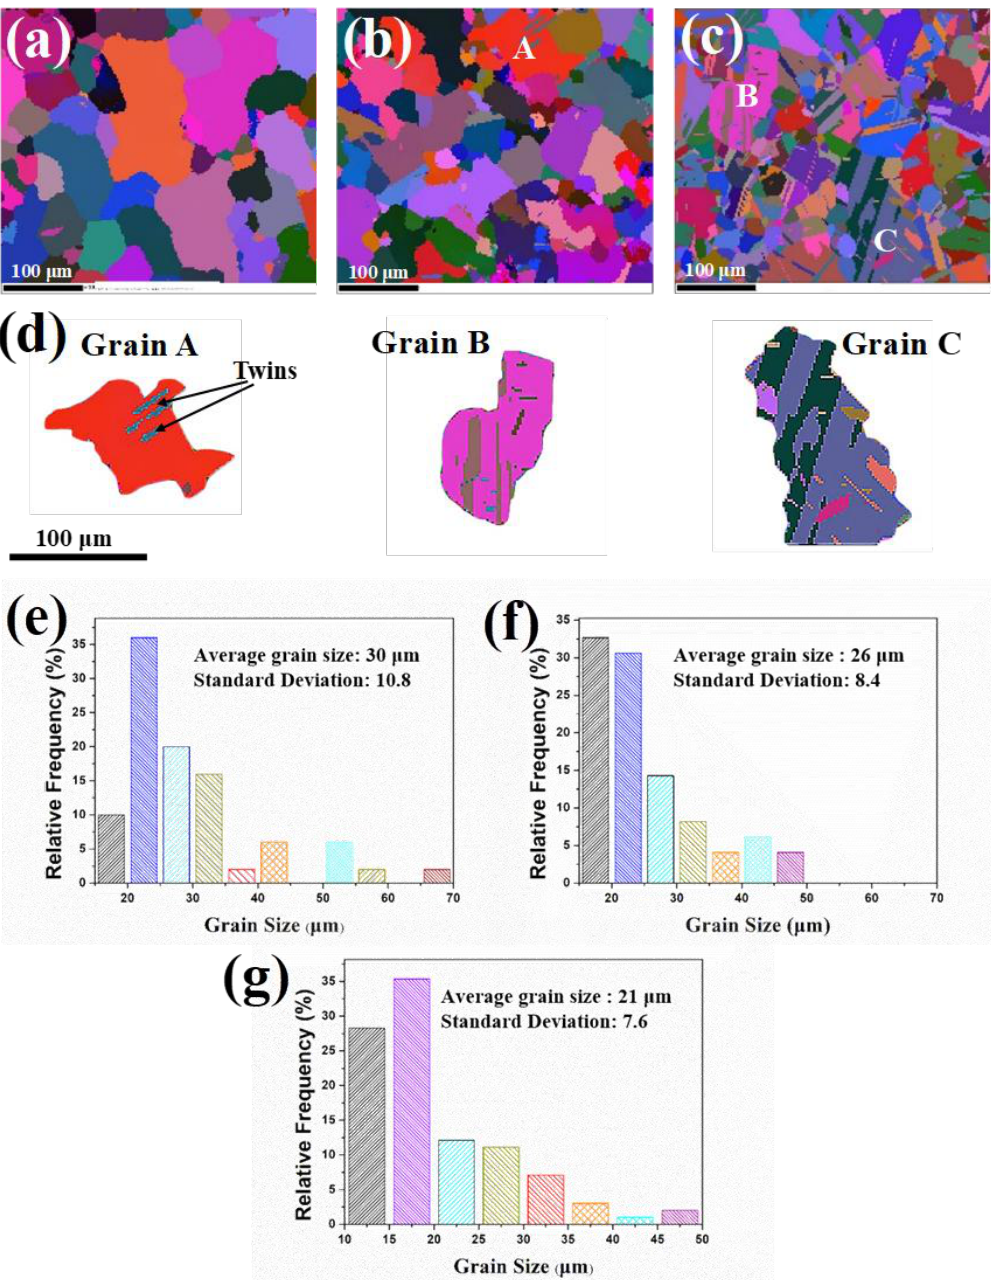
Figure 2. Euler angle map after the pre-hot-deformation with a strain of ( a ) 0, as blank control group, ( b ) 0.2, and ( c ) 0.5; ( d ) shows the large grains of A, B, and C extracted from ( b , c ); ( e – g ) are the corresponding grain size distributions of ( a – c ).